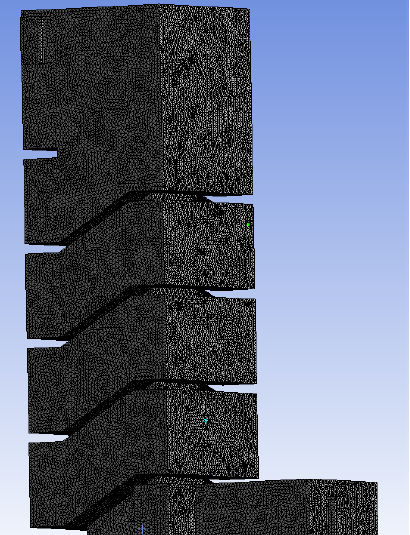
Figure 2. Numerical mesh generated with the use of Ansys ICEM software. The Ansys-FLUENT software (ANSYS, Canonsburg, PA, USA) was applied as a solver [27]. The SIMPLE algorithm was used for pressure velocity coupling. Moreover, used for both the convection terms and the viscous terms of the governing